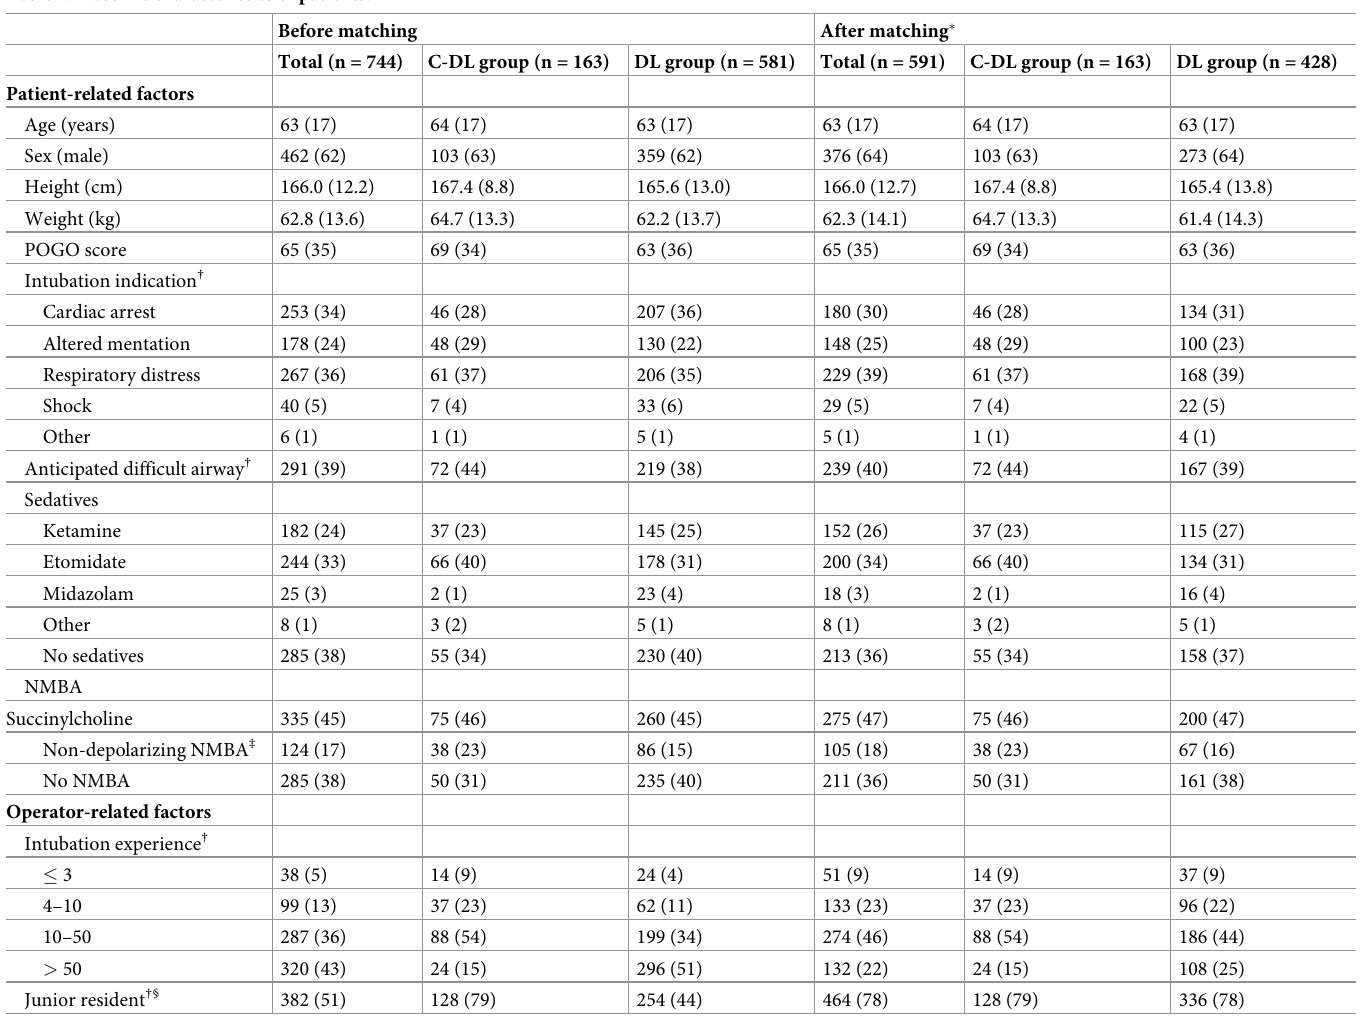
Table 1. Baseline characteristics of patients. Before matching After matching